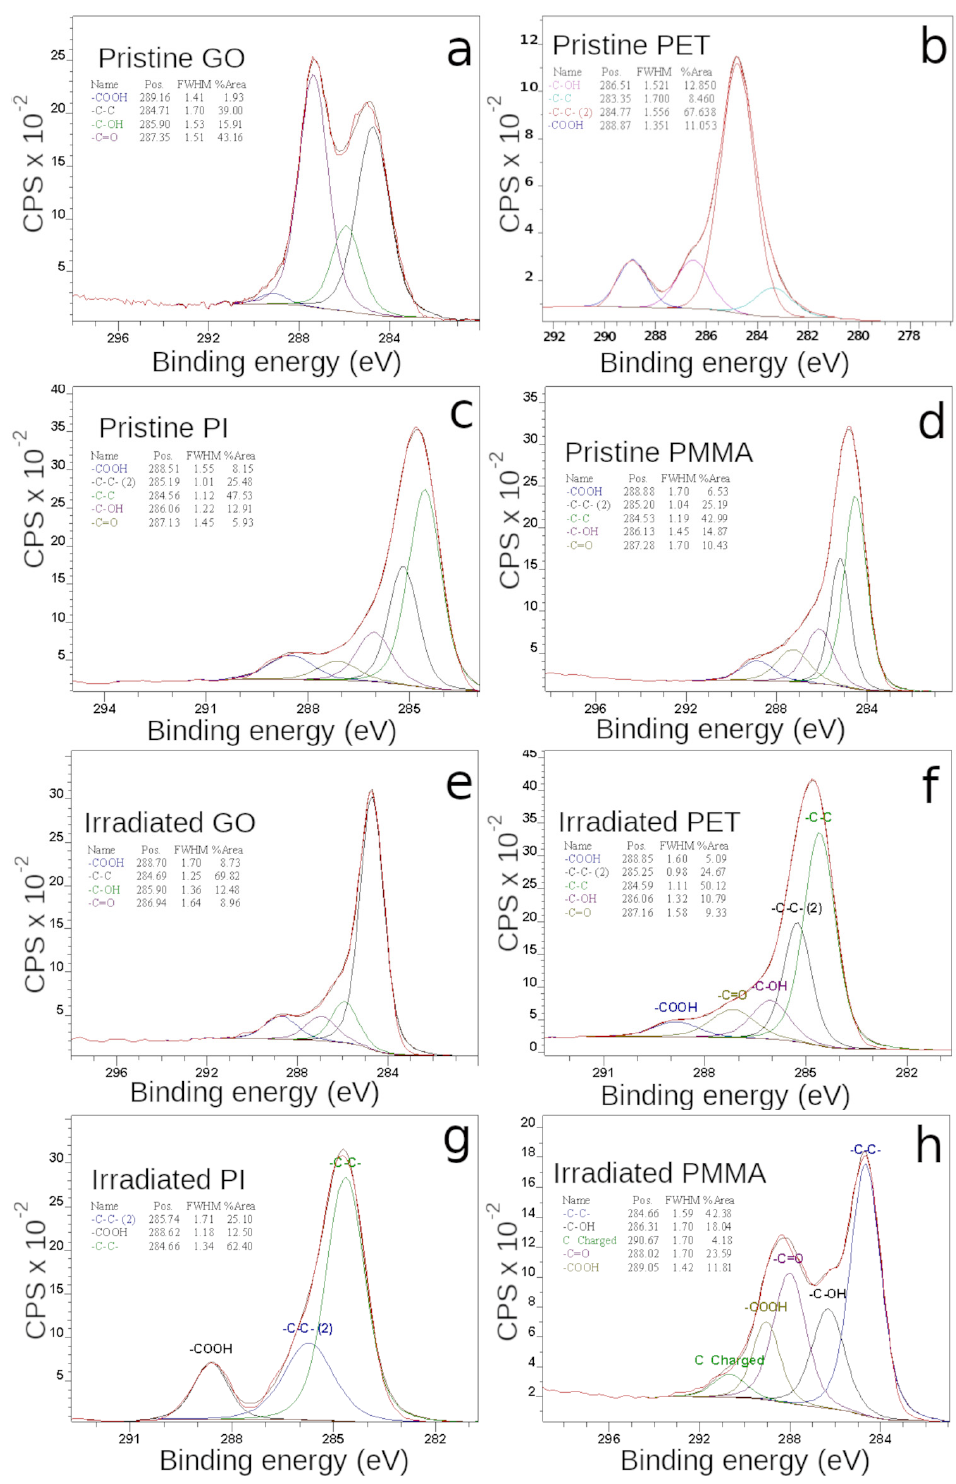
Figure 7. The deconvoluted C1s peaks from high-resolution XPS spectra of pristine and irradiated GO ( a , e ), PET ( b , f ), PI ( c , g ), PMMA ( d , h ). The irradiation was performed with fluence 5.625 × 10 14 cm − 2 . Carbon in the pristine PET is present in three different chemical environments (see Figure 7c): C-C/H (aliphatic/aromatic carbon atoms, 283.35 and 284.77 eV), C-O (methylene carbon atoms, 286.51 eV), and -COO- (ester carbon atoms, 288.87 eV) [62]. The peak corresponding to C=O bonds is not actually observed because it is located and